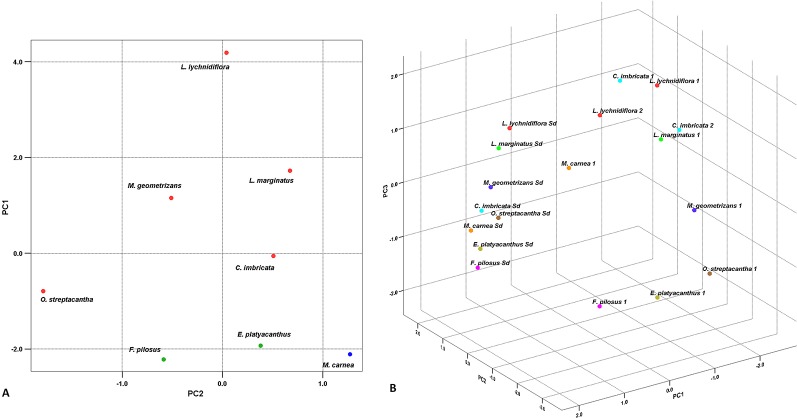
Principal component analysis. (A) Graphic of the eight Cactaceae seedlings based on the first two principal components. The red dots represent the fibrous species, the green dots the dimorphic species, and the blue dot the non-fibrous species. (B) Dispersion graphic in the eight species of seedlings and adults. Colors correspond to each distinct species. Sd seedling. 1 Adult plant from Reyes-Rivera et al. (2015). 2 Adult plant from Maceda et al. (2018).